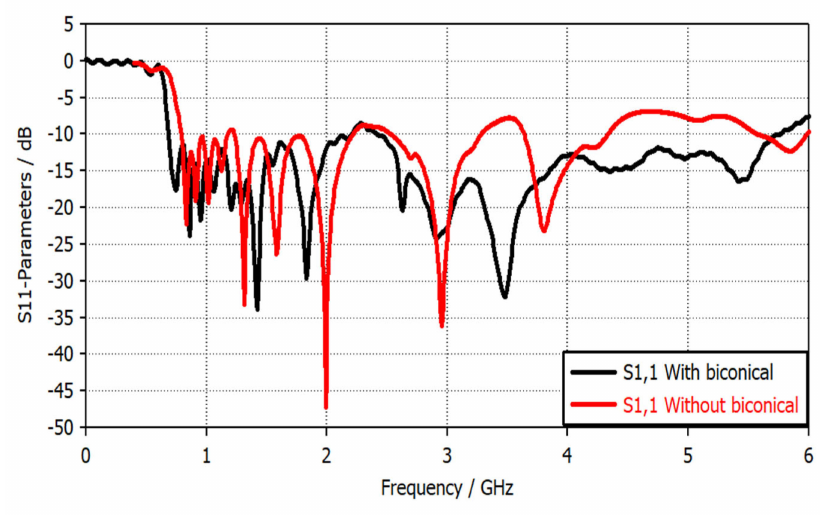
Figure 7. S11-parameter versus frequency with/without biconical structure.